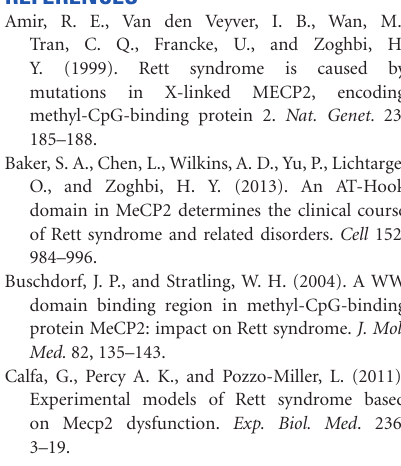
FIGURE 1 | MeCP2 structure and function in gene regulation and chromatin remodeling. (A) A schematic diagram of MeCP2 structure with functional domains and three AT-hook domains. Eight common MeCP2 mutations causing RTT and the two mutants discussed by Baker et al. (2013) are indicated in black and red, respectively. Note that R270X is also one of the most common mutations found in RTT individuals. (B) The function of